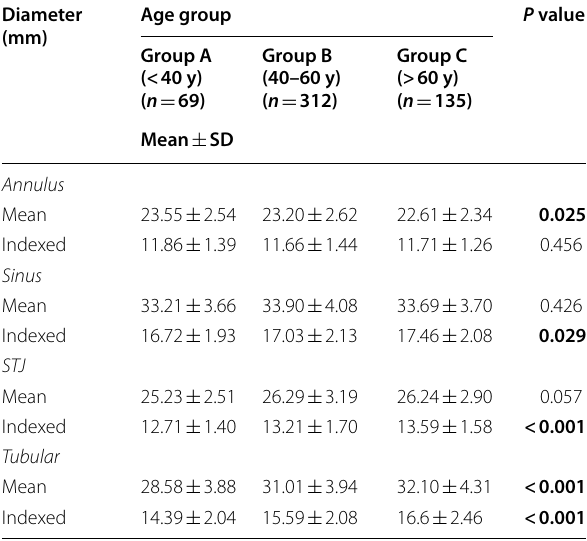
Bold mean significant values that is less than or equal